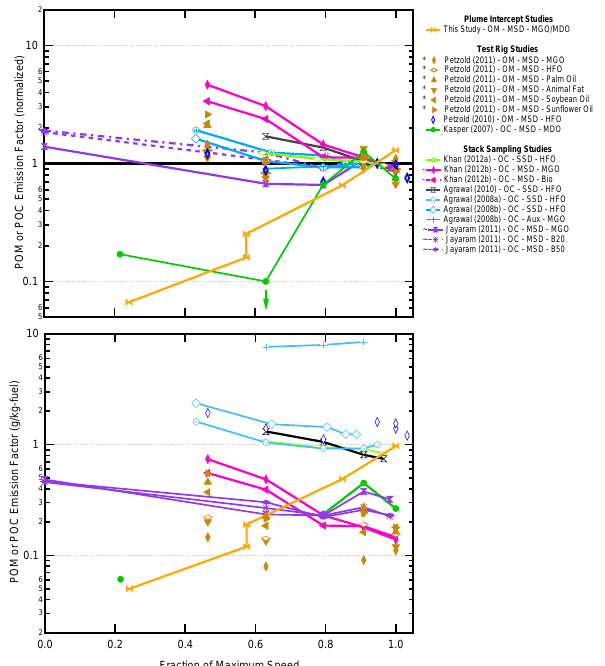
Fig. 7. Measured emissions factors, in g- X per kg fuel for (top to bottom) HCHO, CO, SO 2 and NO x (as NO 2 ) as a function of vessel